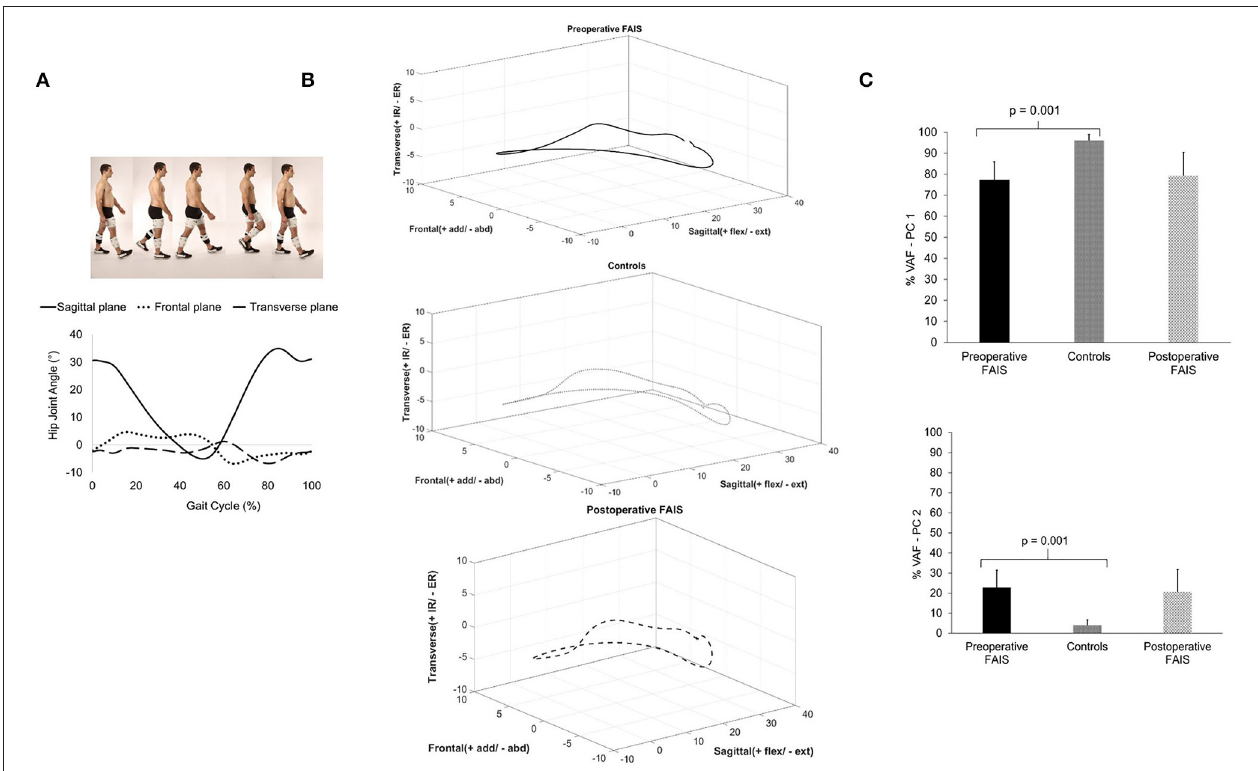
FIGURE 1 | Hip joint kinematic waveforms in each plane during walking (A) were combined to represent the 3D hip joint angle 3D waveforms (B) , which were analyzed using PCA to determine the joint kinematic covariation. The kinematic control strategy of the hip joint for each group was defined as the percent variance accounted for (%VAF) (C)